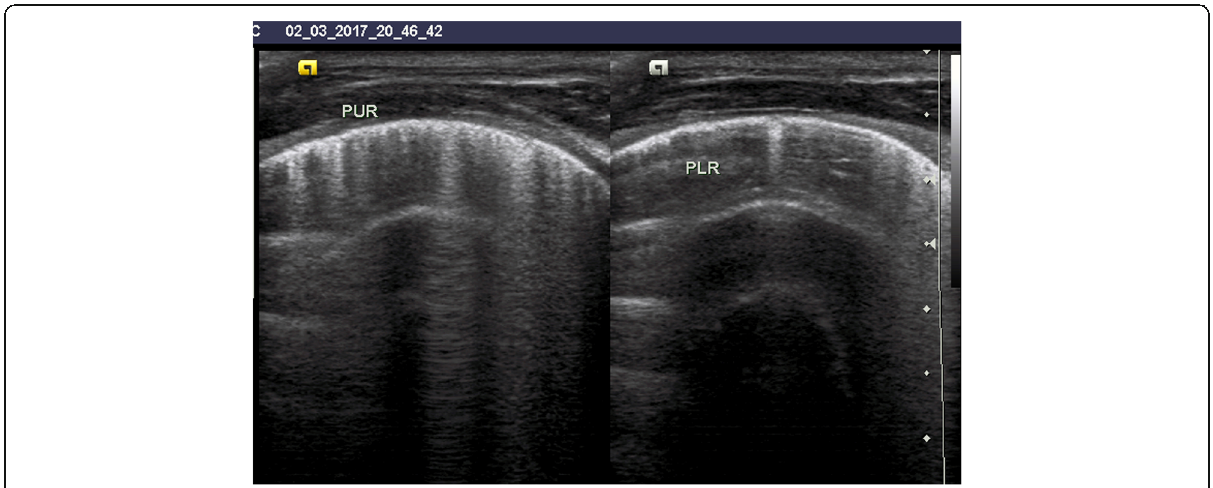
Fig. 3 B-mode ultrasound in the same patient after 3 days of treatment and being on assisted controlled (AC) ventilation. Scanning of the posterior upper and lower zones of the right lung showed improvement of lung aeration with multiple separated B-lines giving a local score of 1. The total lung ultrasound score of the patient was